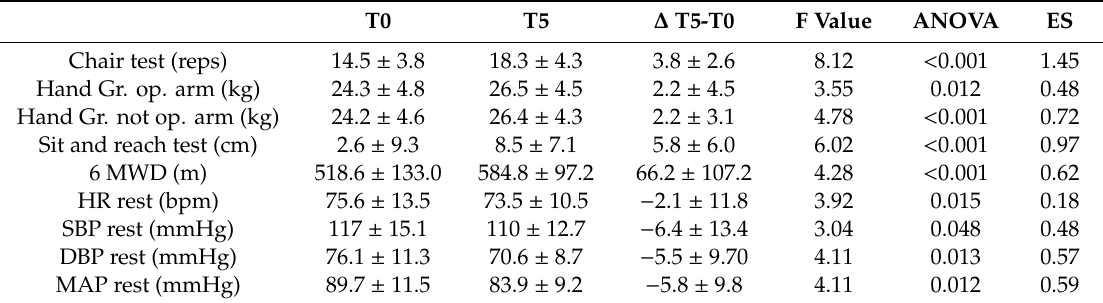
Table 3. Physical fitness parameters related to health during 6 months